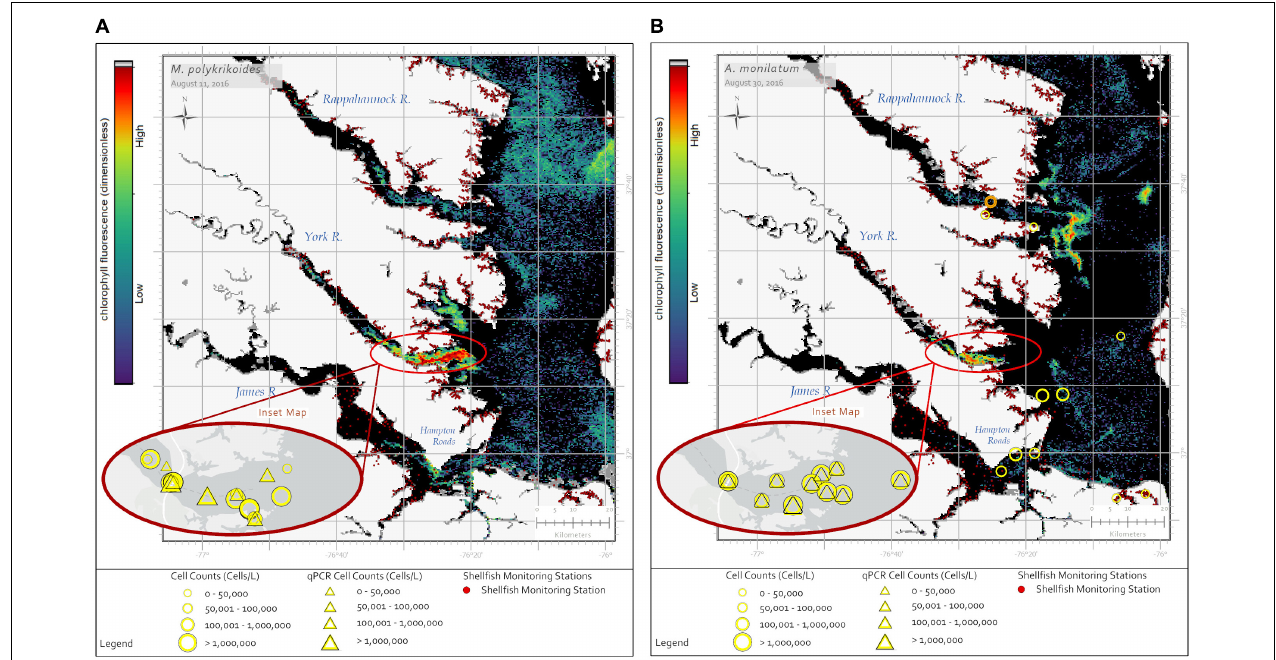
FIGURE 2 | Sentinel-3a OLCI images with RBD algorithm captured two dinoflagellate blooms in late summer 2016. (A) The image from August 11, 2016 shows a bloom of M. polykrikoides in the southern Chesapeake Bay with a concentrated bloom patch off the York River. Yellow circles show in situ cell concentration data obtained using light microscopy for water samples collected August 11–15, 2016. Yellow triangles represent cell concentrations measured using qPCR for the same date range. (B) The image from August 30, 2016 shows a bloom of A. monilatum in the Rappahannock, York, and James Rivers. Yellow circles show in situ cell concentration data obtained using light microscopy for water samples collected August 28 – September 02, 2016. Yellow triangles represent cell concentrations measured using qPCR for the same date range. Data from September 09, 2016 (orange circle) indicate A. monilatum was confirmed in the Rappahannock River a week later. Black pixels indicate no bloom detected. Yellow symbol size represents cell concentration ranges for in situ data. The dark red dots indicate shellfish growing area classification